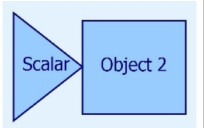
Figure 6. Multiplying an object by a